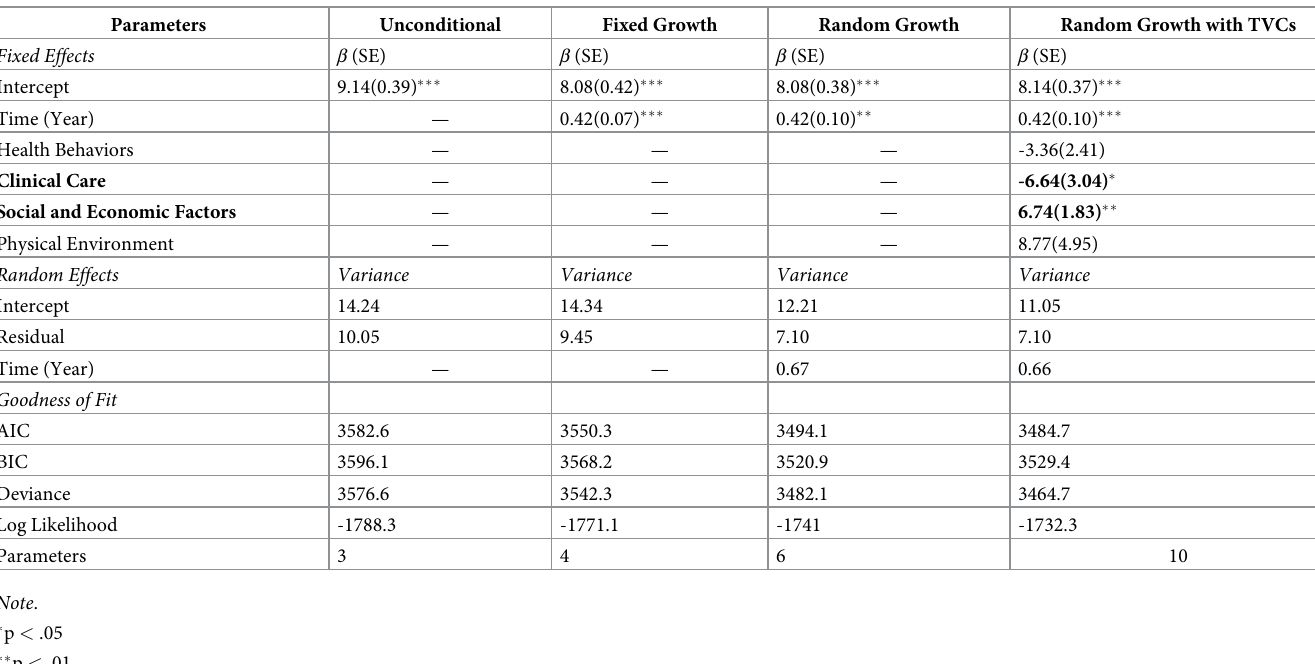
Table 2. Multilevel growth models with socio-ecological risk factors as time-varying covariates